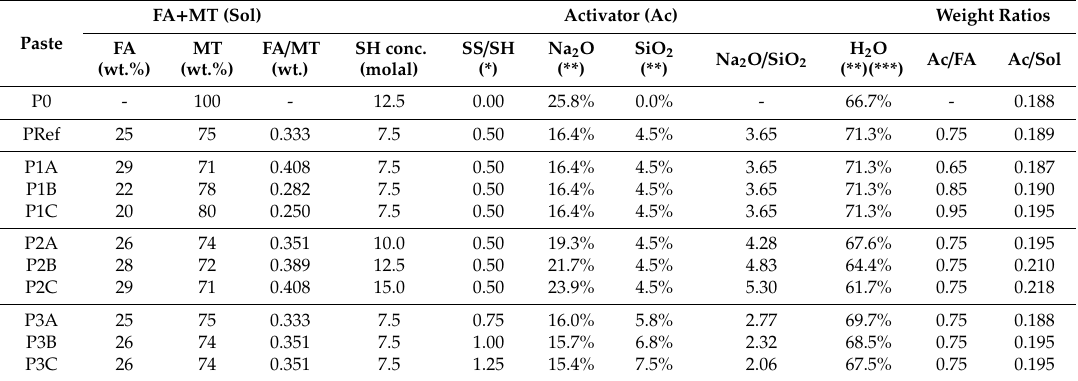
Table 2. Identification and nominal characterization of the pastes FA = fly ash; MT = mine tailings; SH = sodium hydroxide; SS = sodium silicate).